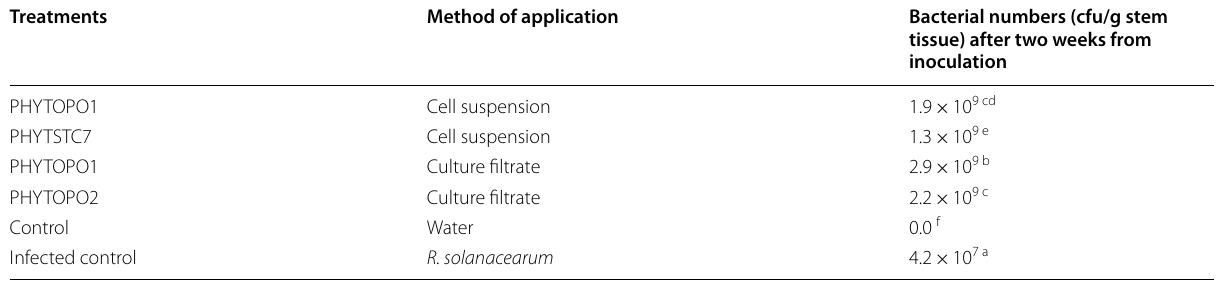
Table 2 Effect of treatment with bacterial bioagents as cell suspension or culture filtrate on number of bacteria in plant under greenhouse